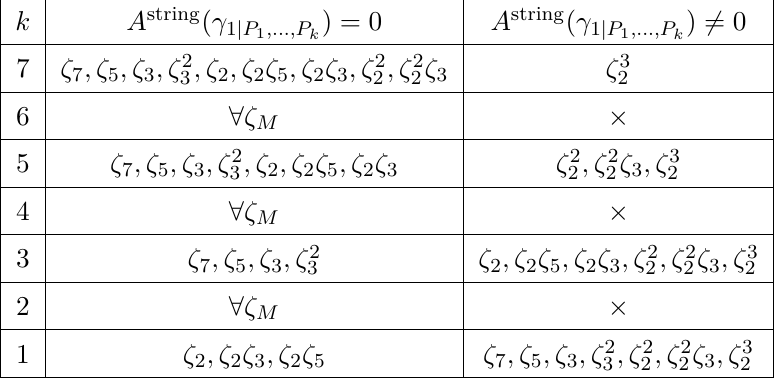
Table 1 . Overview of the descent algebra symmetries of higher α 0 corrections to string disk amplitudes of up to n = 8 points displayed by their MZV content of weight w ≤ 7 . The entries depend only on the number of parts k of the composition of n − 1 . However, a partition with k parts cannot be probed by disk amplitudes with fewer than k +1